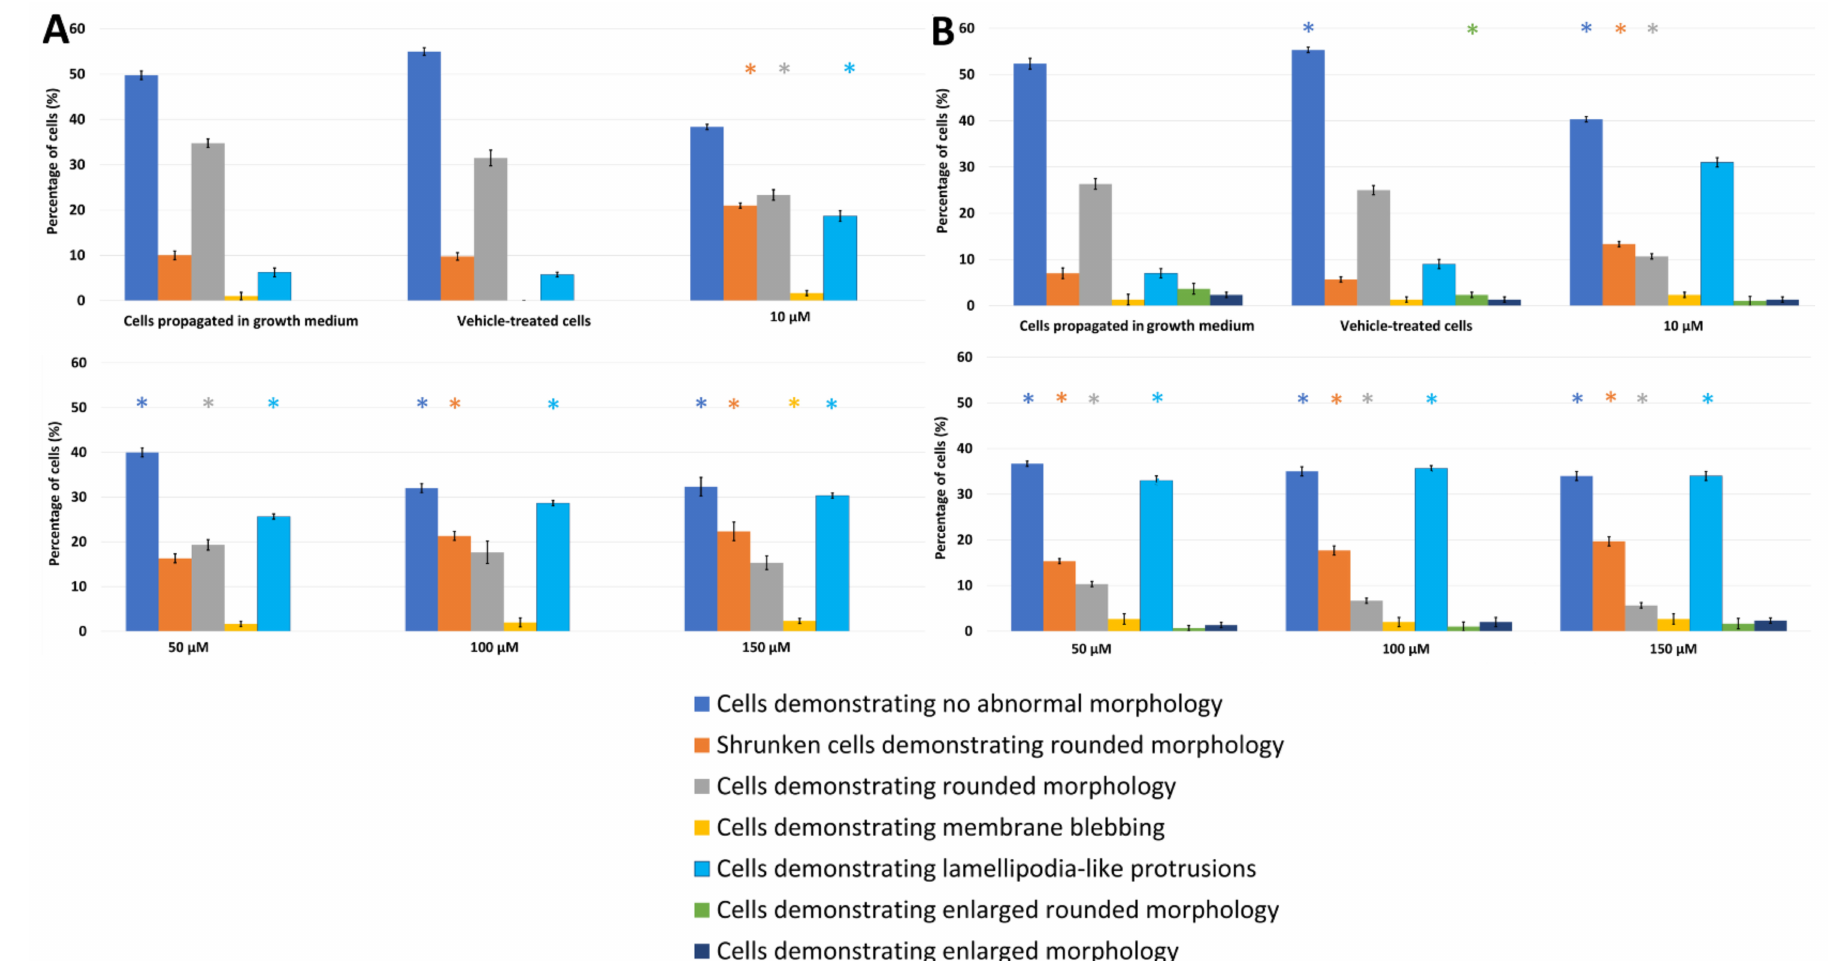
Figure 2. Light microscopy results demonstrating the effects of PPV (10–150 µ M) on cell morphology on MDA-MB-231 cells at 48 h ( A ) and 72 h ( B ). Statistical significance is represented by an * when using the Student t-test with a p value of 0.05 compared to cells propagated in growth medium. Cells demonstrating enlarged and some cells exhibiting enlarged and rounded morphology were not observed after 48